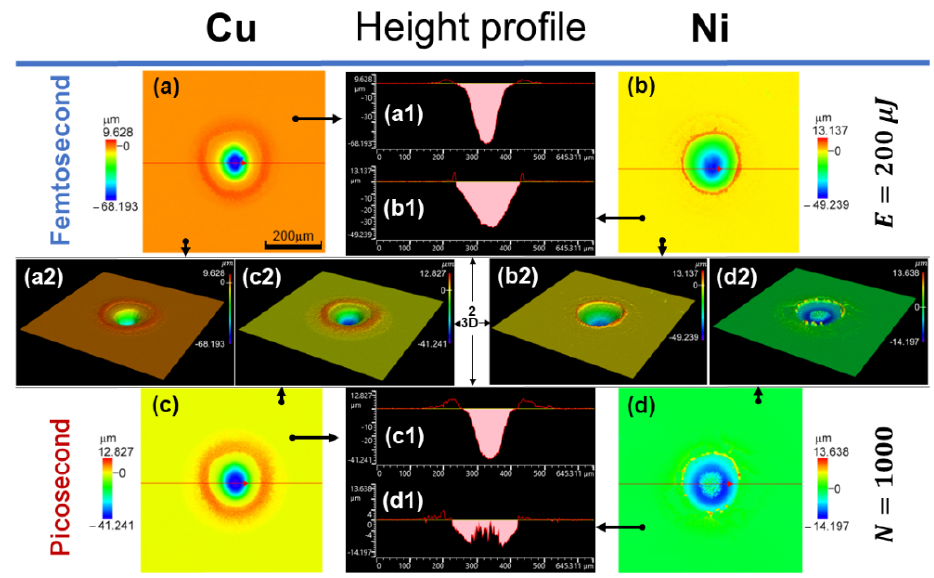
Figure 7. Height profile of copper and nickel after laser irradiation with different pulse widths of energy 200 µ J and pulse number of 1000. (( a , b , c , d ) are the surface ablative morphologies of copper and nickel craters; ( a1 , b1 , c1 , d1 ) are 2D ablative height profiles of copper and nickel craters; ( a2 ), ( b2 ), ( c2 ), ( d2 ) are 3D ablative height profiles of copper and nickel craters).